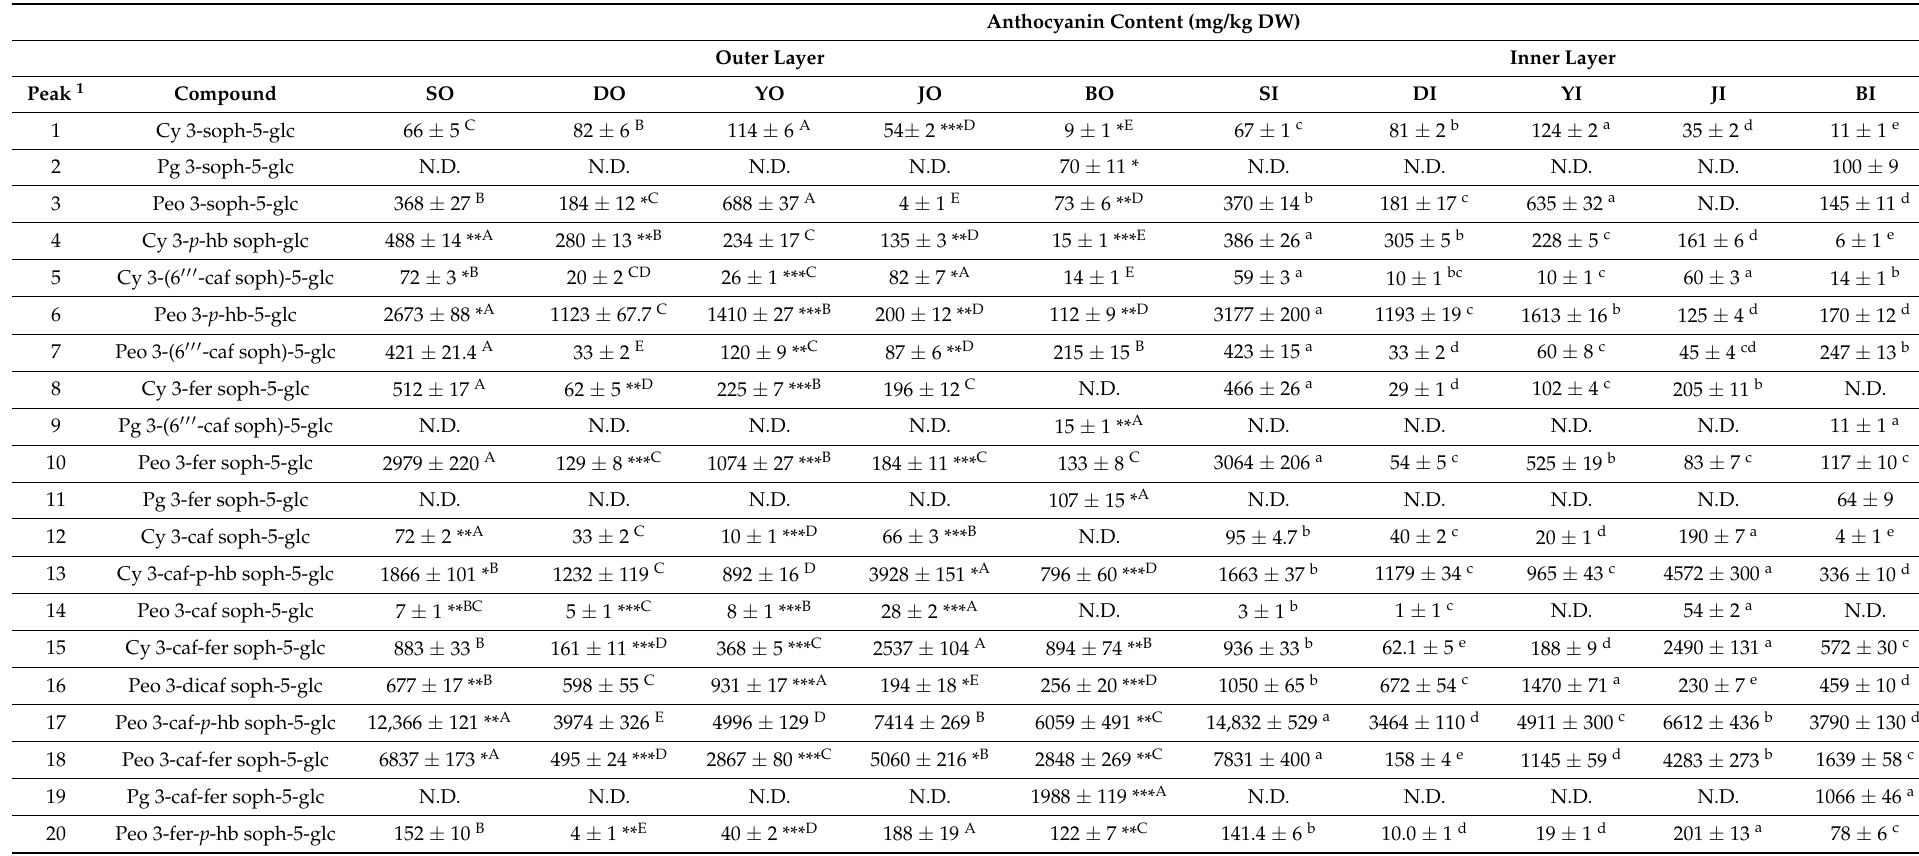
Table 2. Anthocyanin content in purple sweet potato cultivars determined using a high-performance liquid chromatography-photodiode array detector (HPLC-DAD). Anthocyanin Content (mg/kg DW) Outer Layer Inner